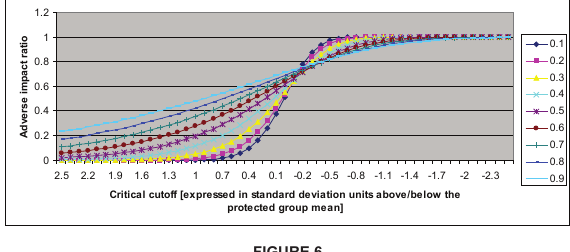
FIGURE 6 Adverse impact ratio as a function of the selection ratio and validity coefficient [difference in mean predicted criterion performance: 0,5 standard deviation units]